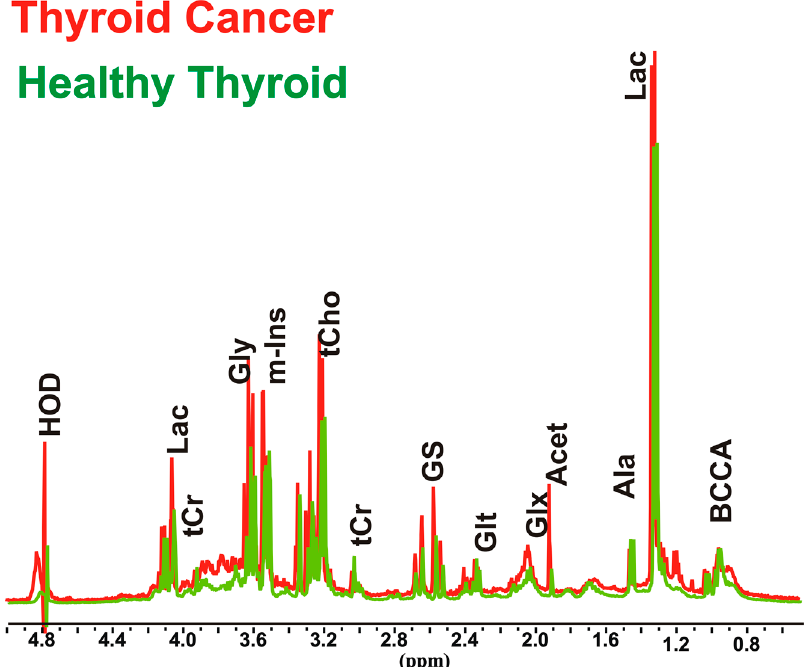
Figure 1. Representative partial 1 H nuclear magnetic resonance ( 1 H-NMR) spectra (9.4 T) of aqueous extracts of thyroid cancer and healthy thyroid tissues. Peak assignment: Acet, acetic acid; Ala, alanine; BCCA, branched amino acids; Gly, glycine; Glx, pool of glutamate, glutamine and glutathione; Glt, glutamate; GS, glutathione; HOD, residual H 2 O; Lac, Lactic acid; m-Ins, myo-inositol; tCr, creatine plus phosphocreatine; tCho, choline containing compounds. Biology 2020 , 9 , x